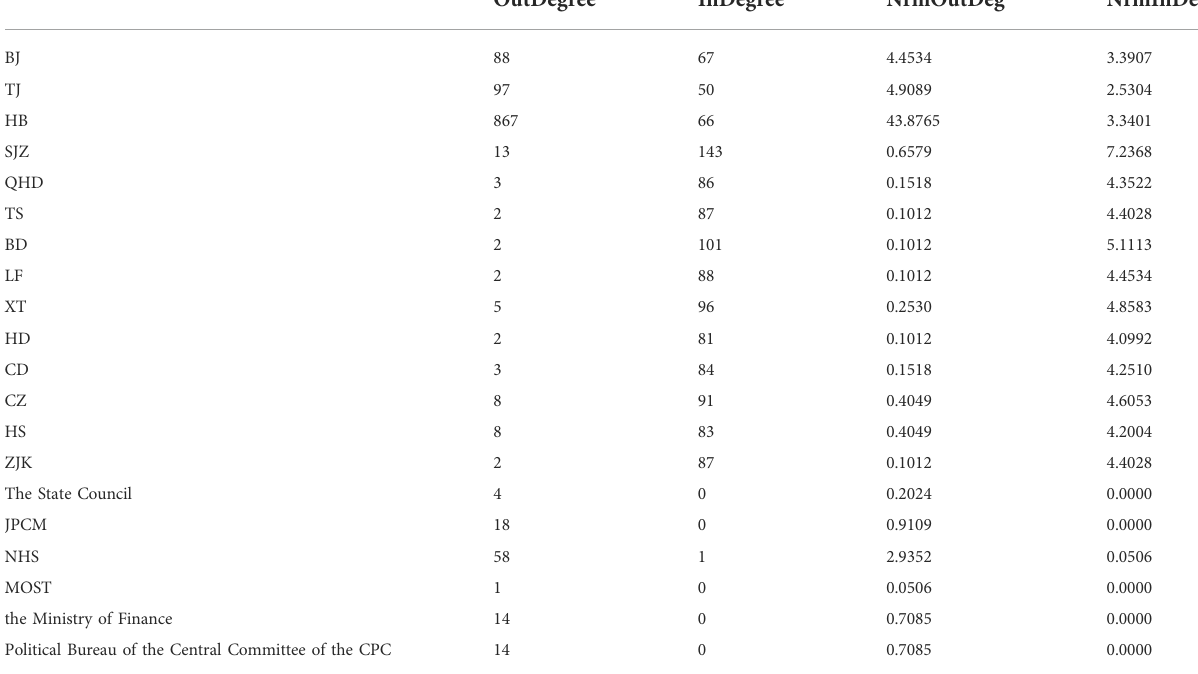
TABLE 3 Degree centrality analysis of the ECSNs for COVID-19 in the B-T-H region.